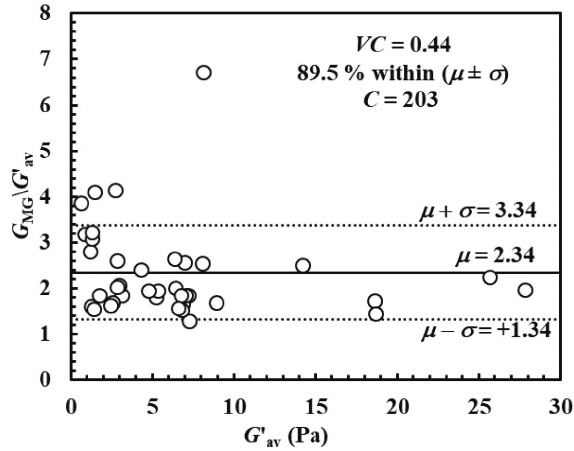
Fig. 4 – Dependence of the ratio G /G’ (open circles) ver- MG av sus G’ . G indicates the samples shear modulus evaluated av MG according to the MG strategy while (G’ ) is the arithmetic me- av dia of the experimental G’ values referring to each sample. VC is the variation coefficient (ratio between the average value, m , and the standard deviation, s ) while C is the ratio between the percentage of data falling within the ( m ± s ) and the standard deviation s